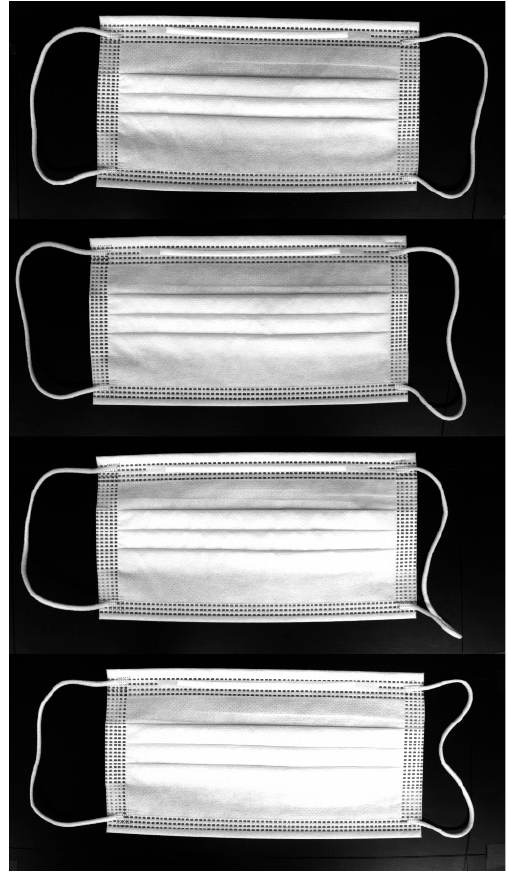
Figure 5. Mask image from a multi-vision system in a mask production line.